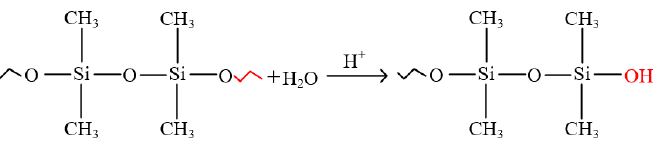
Figure 8. The formation of Si–OH bonds due to the reaction between the acid and silicone rubber [52]. Table 4. Silicone rubber compounds tested for enhancing acid stability